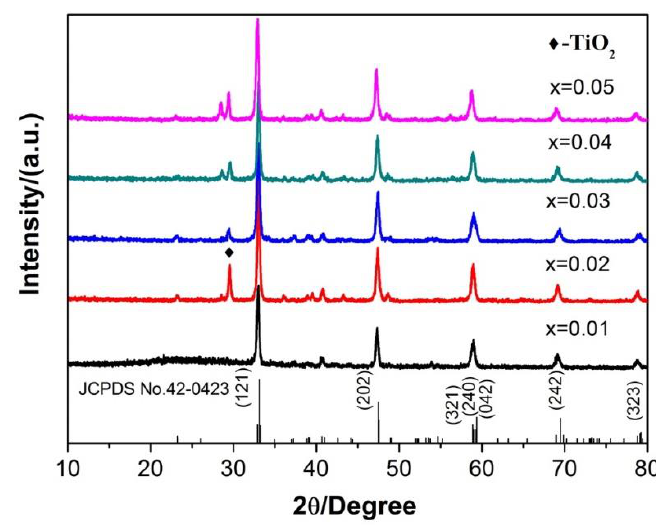
Figure 6. XRD patterns of the Ca 1-x TiO 3 :Eu 3 + x phosphors doped with various concentrations of Eu 3 + synthesized by the traditional sintering processes.